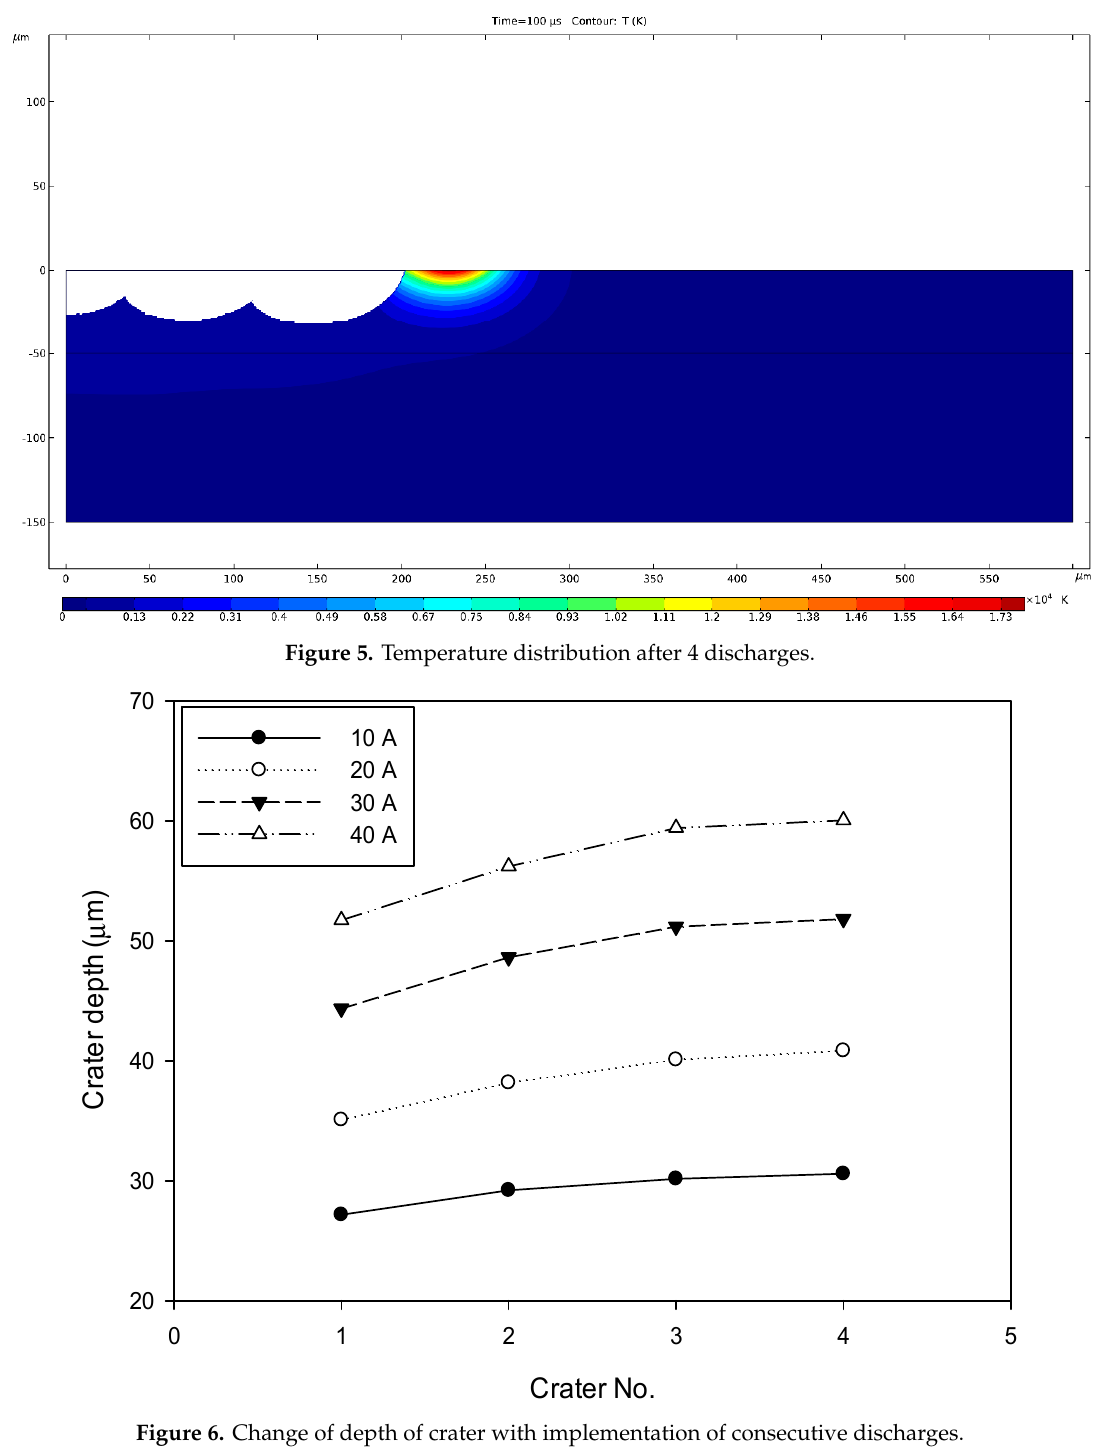
Figure 6. Change of depth of crater with implementation of consecutive discharges.